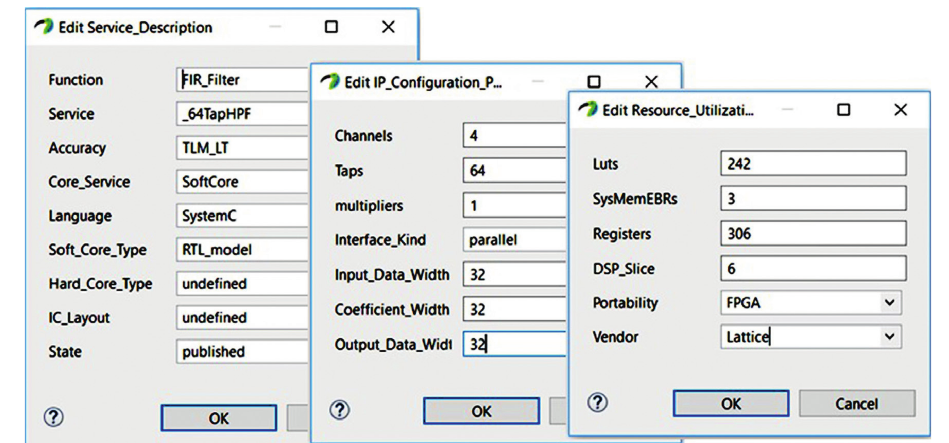
Figure 14: Assigning values to service